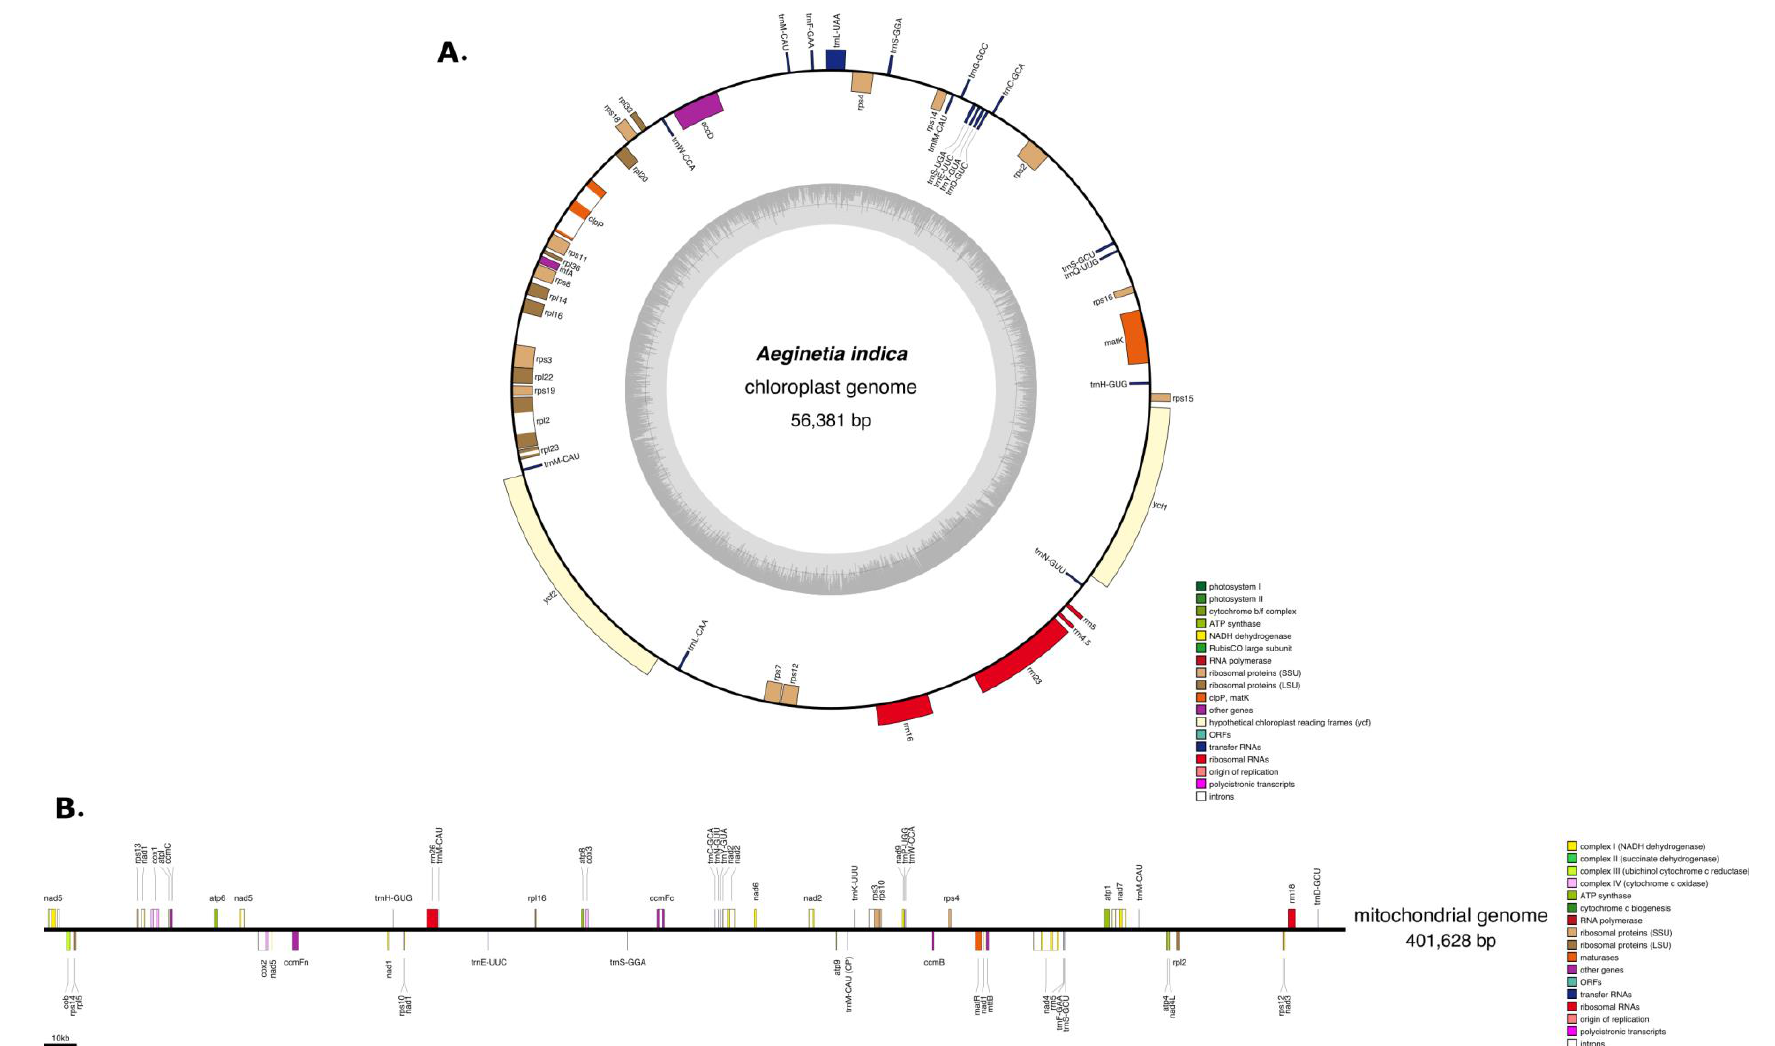
Figure 1. ( A ) Chloroplast genome of Aeginetia indica . ( B ) Mitochondrial genome of A. indica . Top and bottom genes are transcribed in forward and reverse directions, respectively.